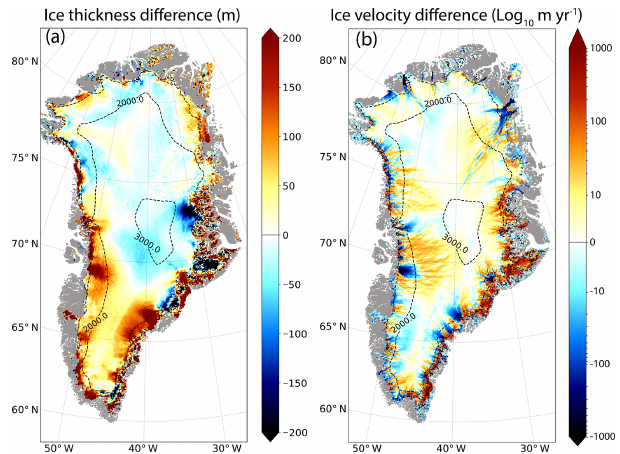
Figure 4. (a) Ice thickness difference (m) simulated at the end of a 200-year-long simulation without any specific initialisation proce- dure with respect to the observed ice thickness from Bamber et al. (2013). (b) Difference (myr − 1 ) between the surface ice velocity in the same simulation and the observed surface velocity from Joughin et al. (2018). The dashed lines correspond to the 1000m surface el- evation iso-contours for the simulated topography. Grey areas rep- resent non-ice-covered areas. A logarithmic scale is used for the ice velocity